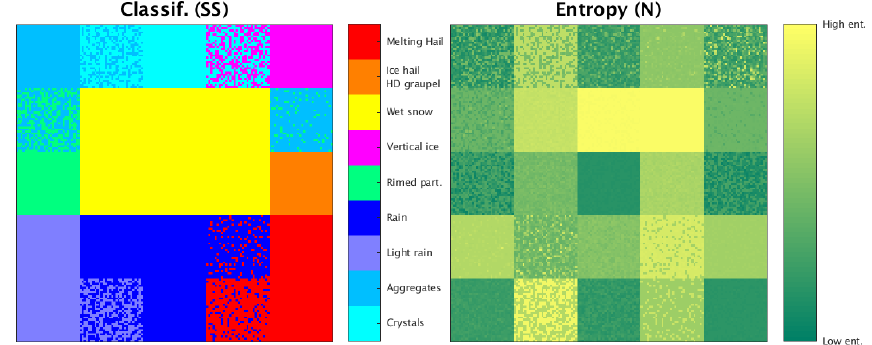
Figure 6. Classification and entropy applied to the synthetic dataset from Fig. 5. Low and high entropy values correspond to the limits of the range [ 0 , 1 ] .